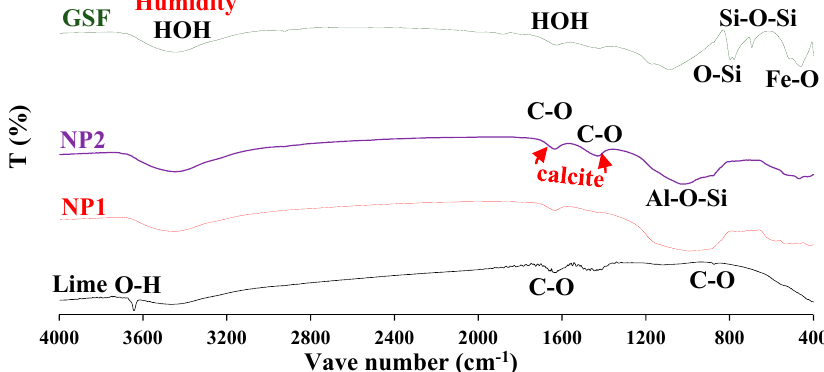
Figure 5. XRD analysis of fine powders. Al: albite, An: anorthite, Au: augite, E: enstatite, D: diopside, F: frosterite, M; mullite Qz: quartz.